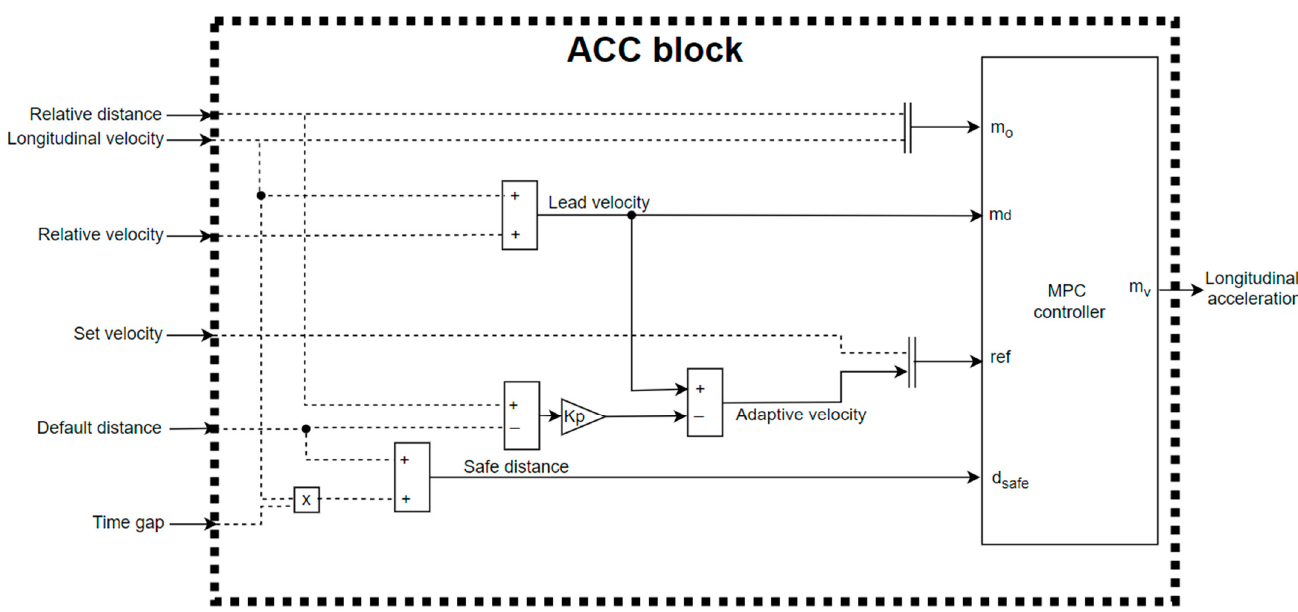
Figure 5. Adaptive cruise control block diagram.